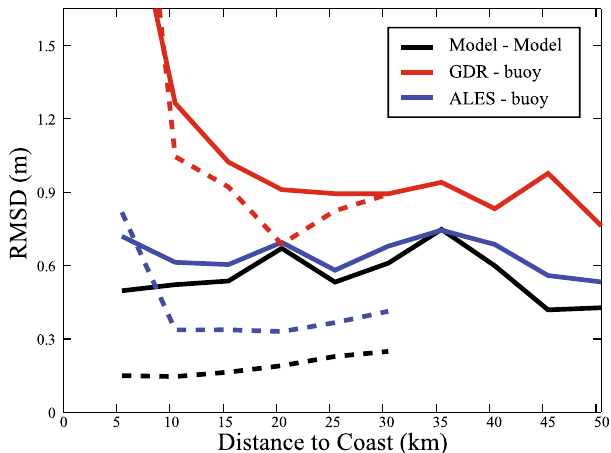
Fig. 8 Coastal comparison between buoys, altimetry, and reanalysis. Root Mean Square Difference (RMSD) of observations at altimeter point and at buoy location, with respect to the distance to coast binned every 5 km. Black lines indicate comparison of reanalysis at the two locations; red and blue are for standard Geophysical Data Records (GDR) and this study (ALES) respectively compared with the buoys. Solid line shows all comparisons; dashed line shows results for pairings deemed highly coherent i.e., for which the reanalysis comparison has r ≥ 0.95 and RMSD ≤ 0.3